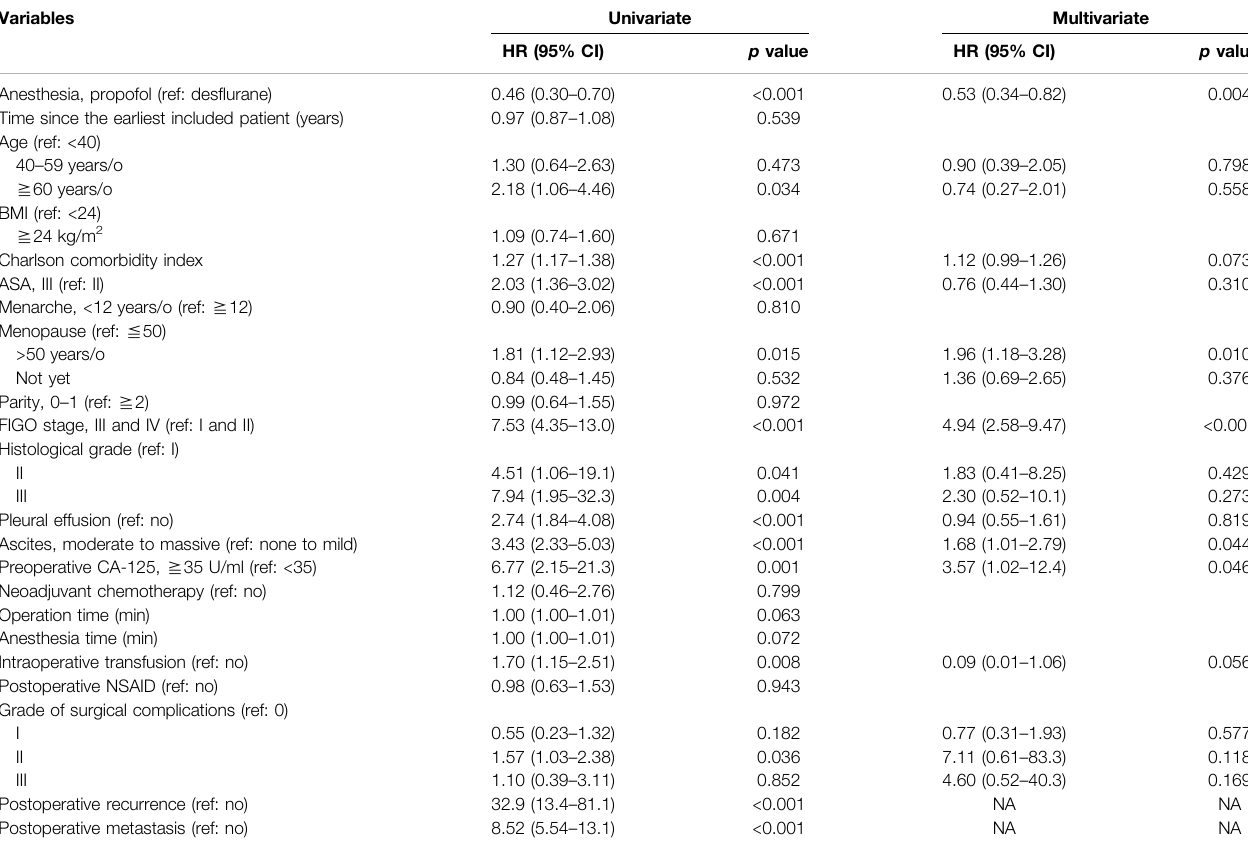
TABLE 2 | Cox proportional hazards regression for mortality: univariate and multivariate models for overall